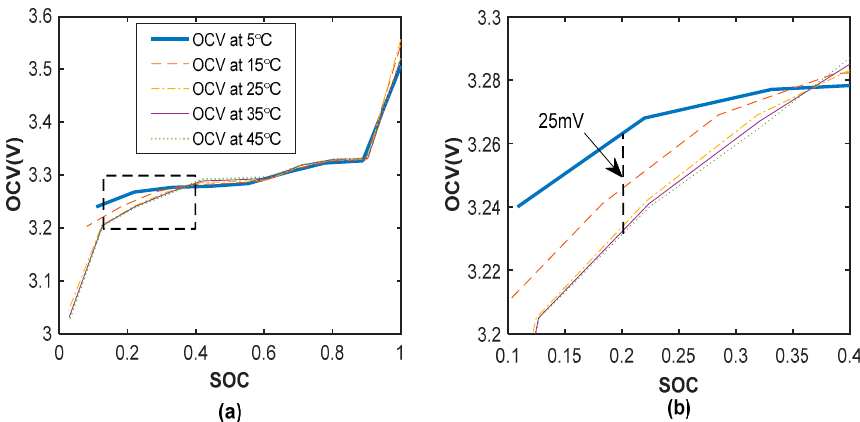
Figure 3. ( a ) Experimental results of OCV-SOC at different temperatures; ( b ) details of SOC value from 0.1 to 0.4. Energies 2018 , 11 , x